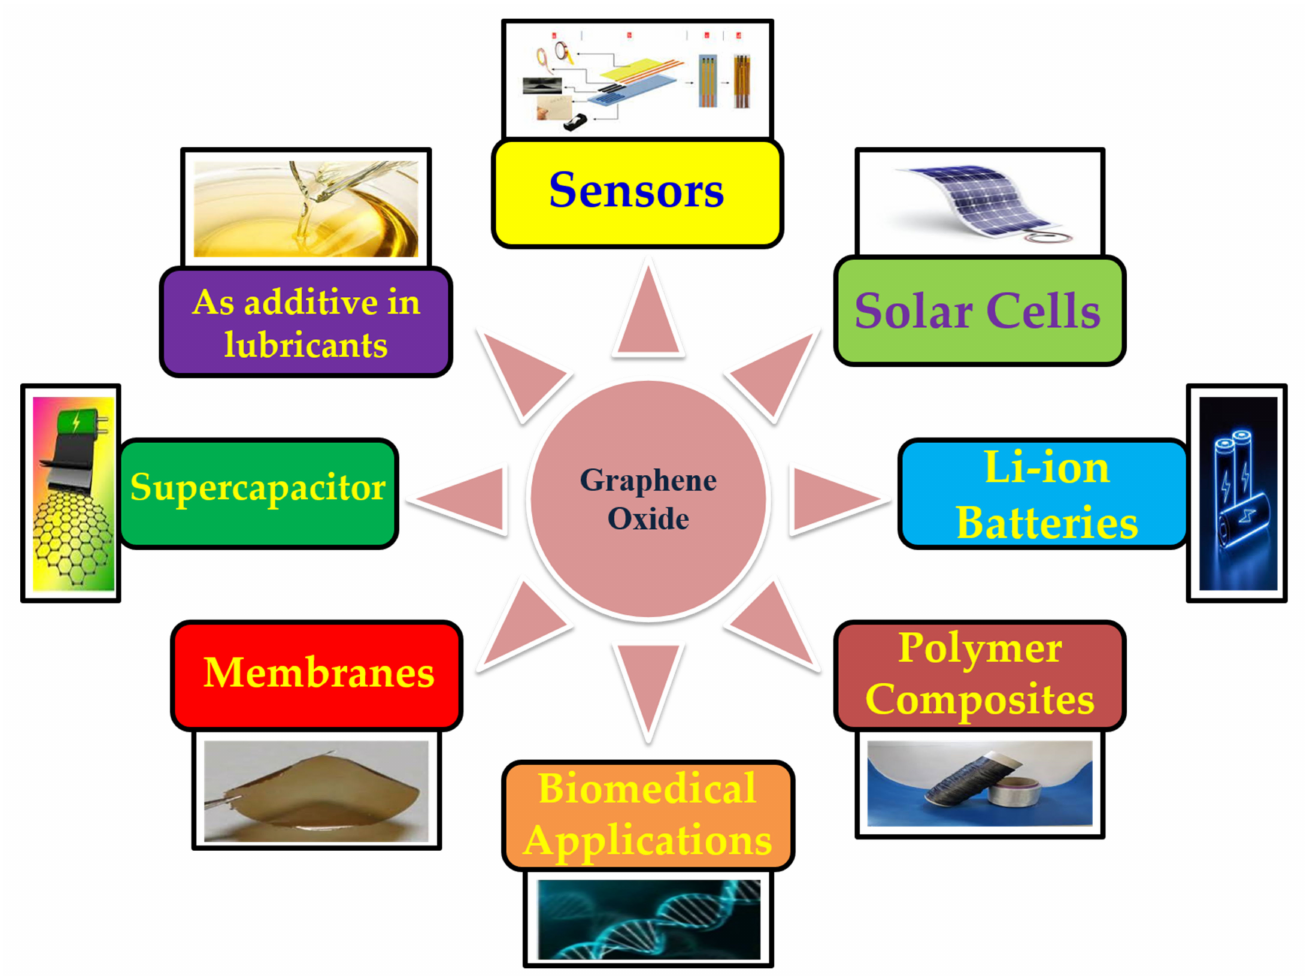
Figure 10. Schematic representation of the various applications of graphene